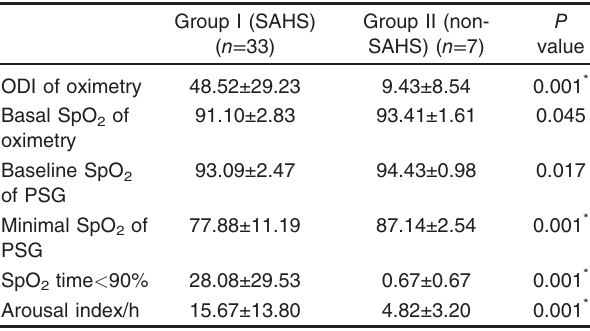
Table 3 PSG and overnight pulse oximetry variables in the SAHS group versus the non-SAHS group